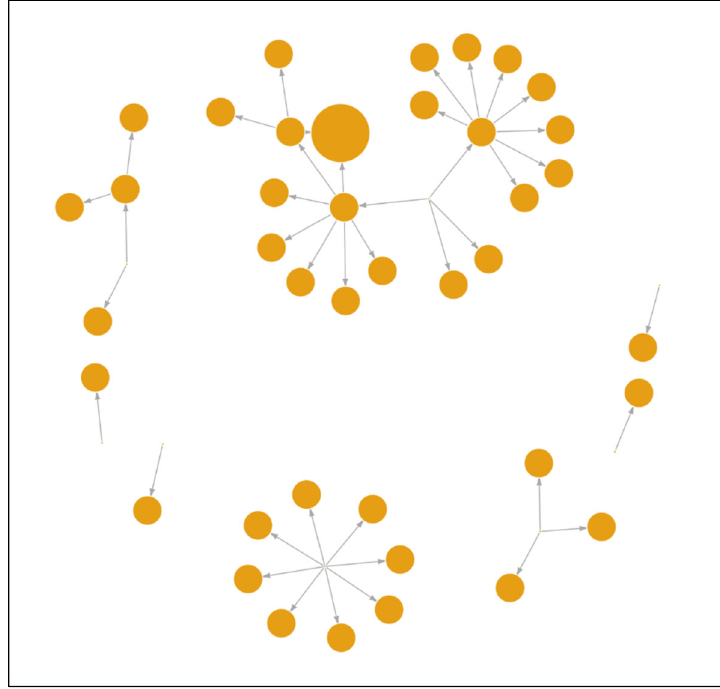
Figure 3: Social Network Analysis (SNA) of Food Transaction Relationships among Food System Organizations Working in an Eight-County Region of Northeastern North Carolina Node size reflects incoming